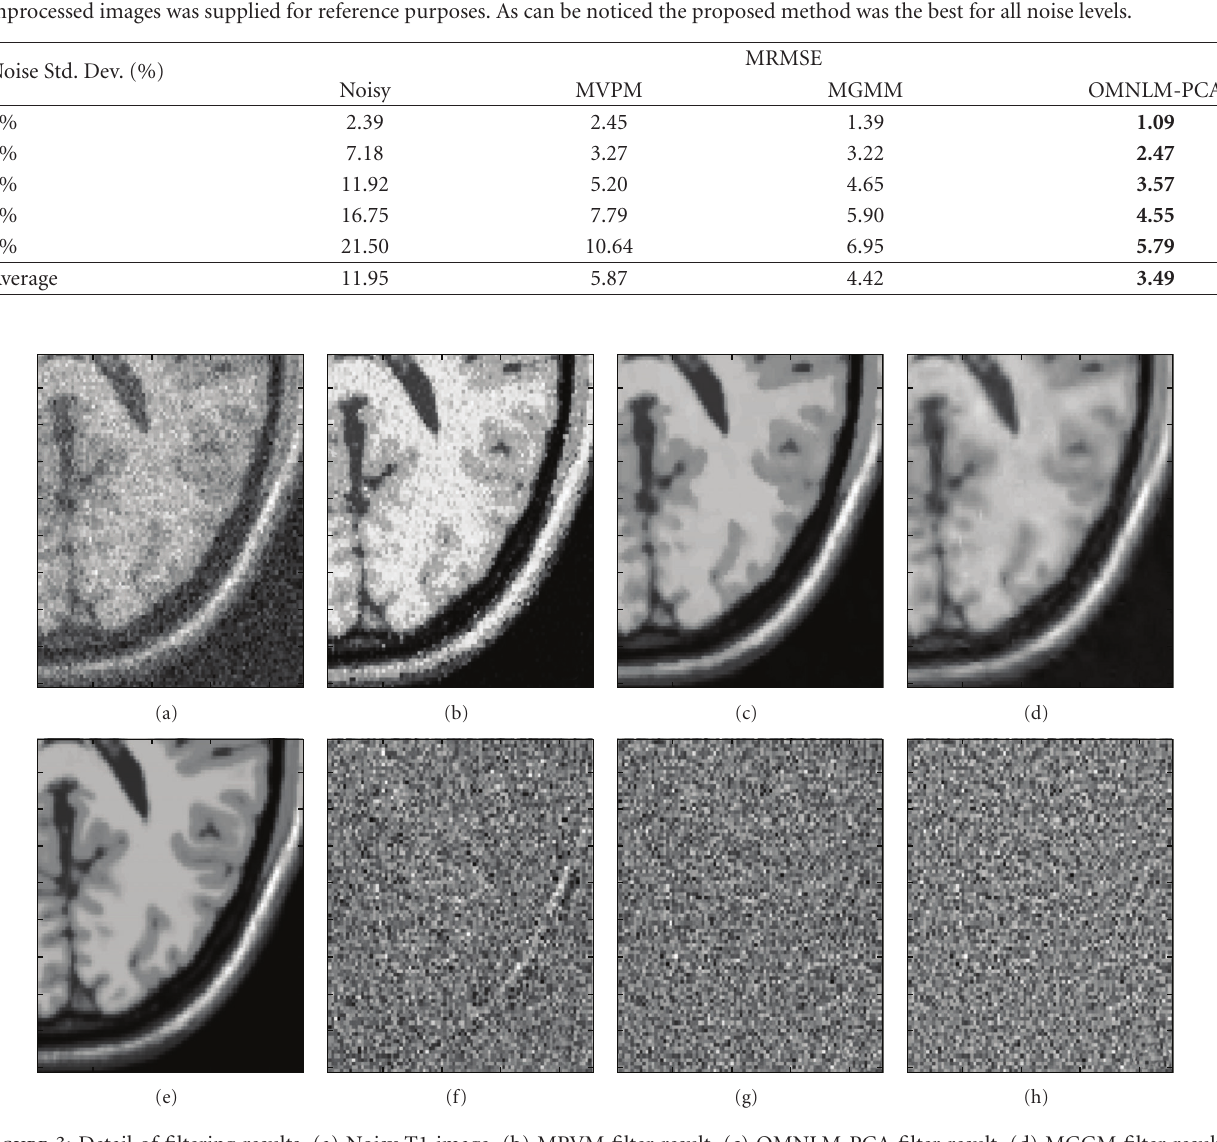
Figure 3: Detail of filtering results. (a) Noisy T1 image. (b) MPVM filter result. (c) OMNLM-PCA filter result. (d) MGGM filter result. (e) Noise Free T1 image. (f) MPVM residuals. (g) OMNLM-PCA residuals. (h) MGGM residuals. As can be noticed, almost no anatomical information is visible in the image residuals for the compared methods (except for MPVM). However, with the proposed method, the image details are better preserved than the